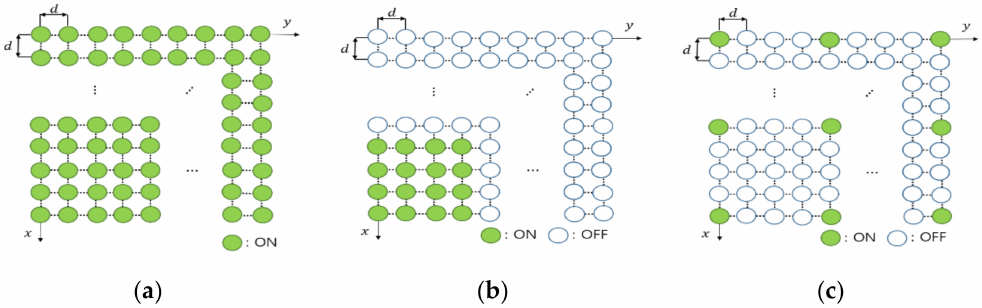
Figure 1. Examples of the flexible antenna array: ( a ) turning on entire antenna elements, ( b ) turning on some concentrated array elements, ( c ) turning on some scattered array